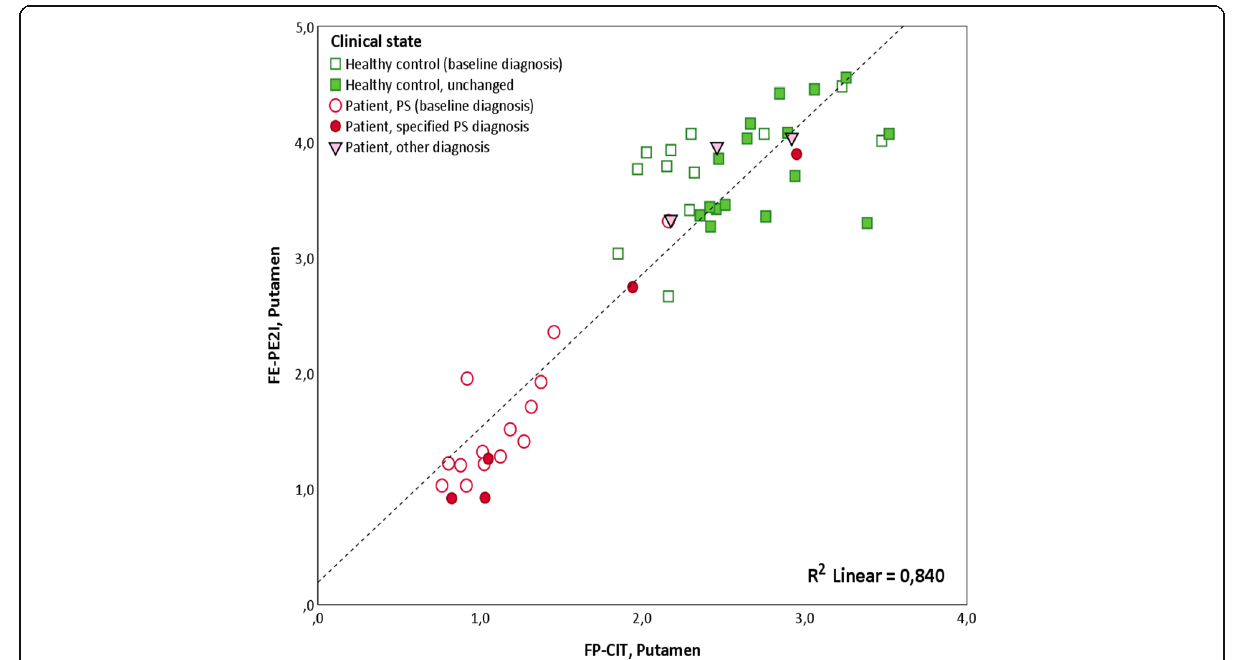
Fig. 5 DAT availability in the putamen measured with FE-PE2I versus FP-CIT. Scatterplot of DAT availability in the putamen measured with FE-PE2I (BP ND ) versus FP-CIT (SUR) in patients and HC. DAT measurements are mean of the left and right putamen. Empty squares indicate HC that are not yet followed up. Filled squares indicate HC that are still healthy at follow-up after 2 years. Filled circles indicate patients that fulfilled clinical criteria for PS at inclusion and fulfilled clinical criteria for a specific parkinsonian syndrome at follow-up after 2 years. Empty circles indicate patients that fulfilled clinical criteria for PS at inclusion, not yet clinically followed up. Filled triangles indicate patients that fulfilled clinical criteria for PS at inclusion, but did not fulfil clinical criteria for a specific parkinsonian syndrome at follow-up after 2 years. DAT, dopamine transporter; BP ND , binding potential relative to non-displaceable binding; SUR, specific uptake ratio; FE-PE2I, [ 18 F]FE-PE2I PET; FP-CIT, [ 123 I]FP-CIT SPECT;